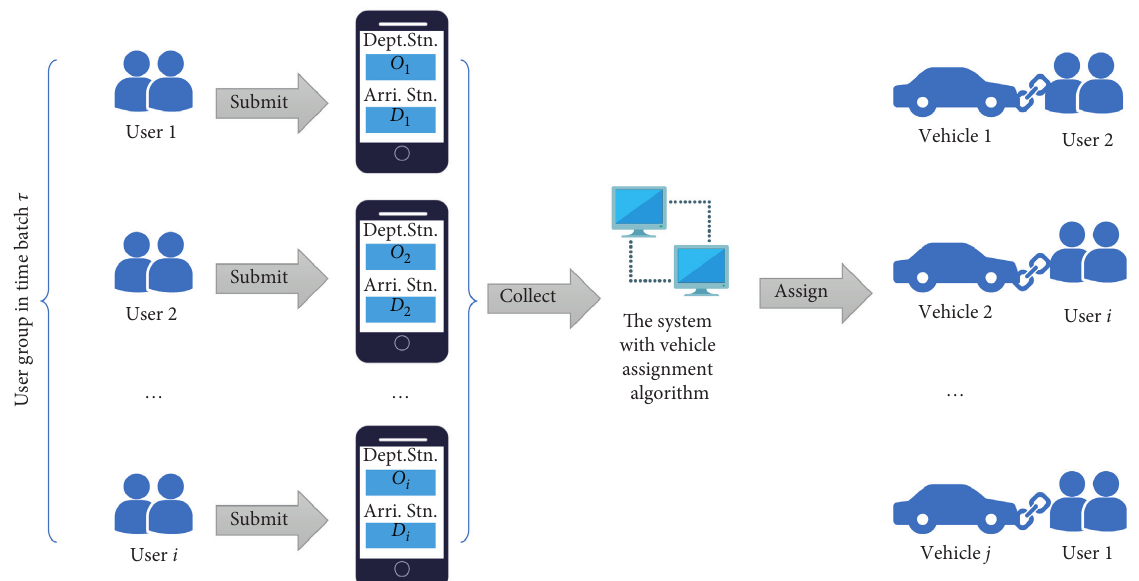
Figure 3: User interaction and vehicle assignment of short-term reservation